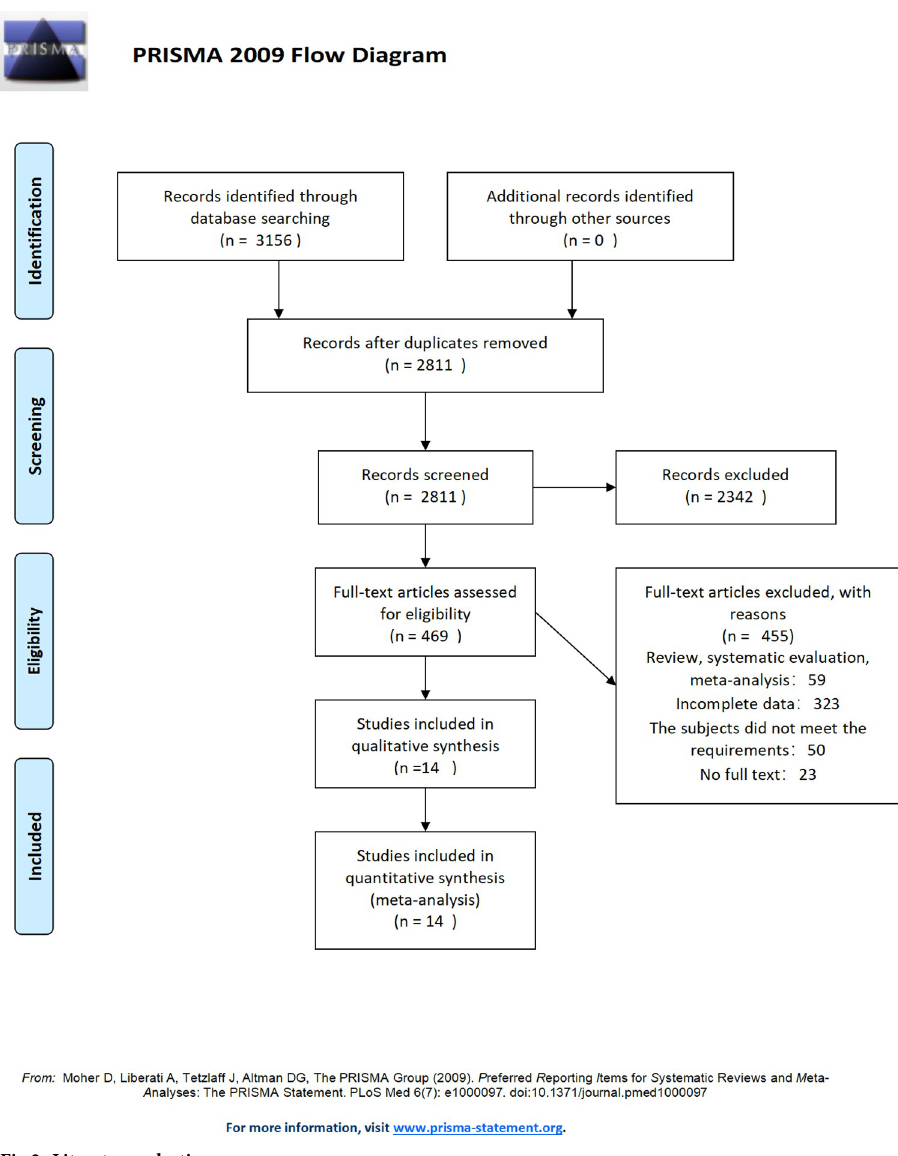
Fig 2. Literature selection